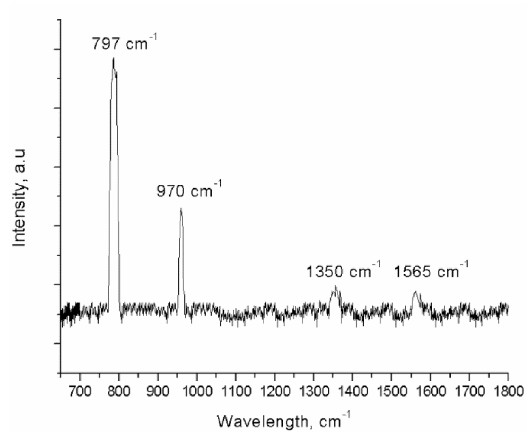
Figure 9. Raman spectrum of SiCNTs synthesized from blend of and MWCNTs in the ratio of SiO 2